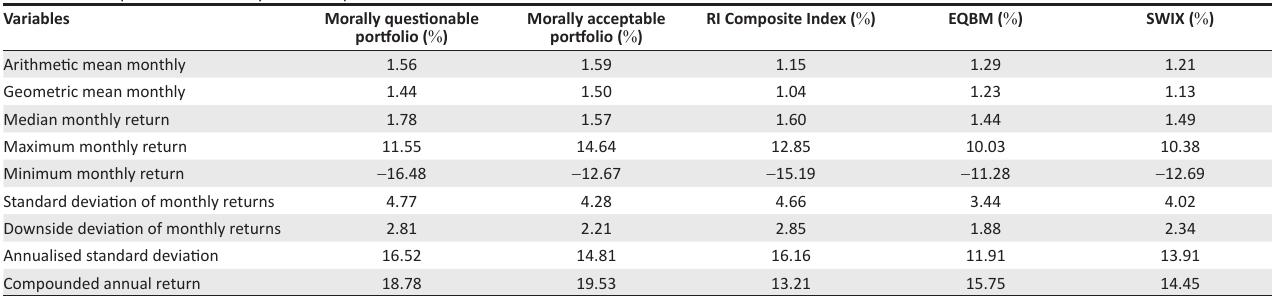
TABLE 1: Descriptive statistics: July 2004 to April 2019.